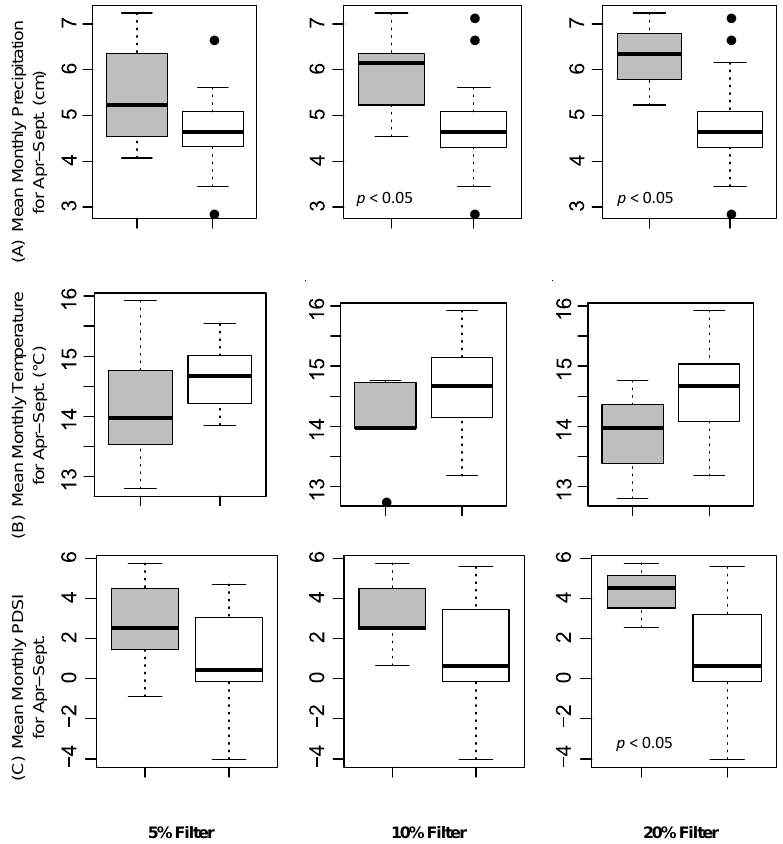
Figure 5. Comparison of ( A ) mean monthly precipitation (cm), ( B ) mean monthly temperature ( ◦ C), and ( C ) mean monthly Palmer Drought Severity Index (PDSI) index values during establishment years (gray boxes) versus non-establishment years (white boxes) for the combined dataset of all sites. Establishment years are defined as years in which a minimum percentage (5%, 10%, or 20%) of all ponderosa pine and Douglas-fir seedlings established. p -values are provided when differences are significant at the p < 0.05 level, according to Mann-Whitney tests. Climate data used are from the National Climatic Data Center (NCDC), Division 4 of